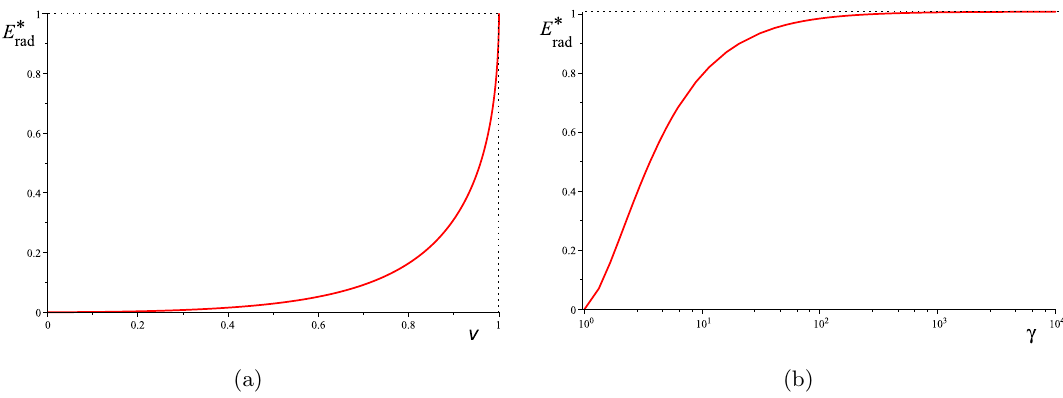
Figure 8 . The emitted radiation against the speed of particle ( a ) and Lorentz factor (in logarithmic mode) ( b ) in D = 7 dimensions, normalized by the maximal value given by eq.